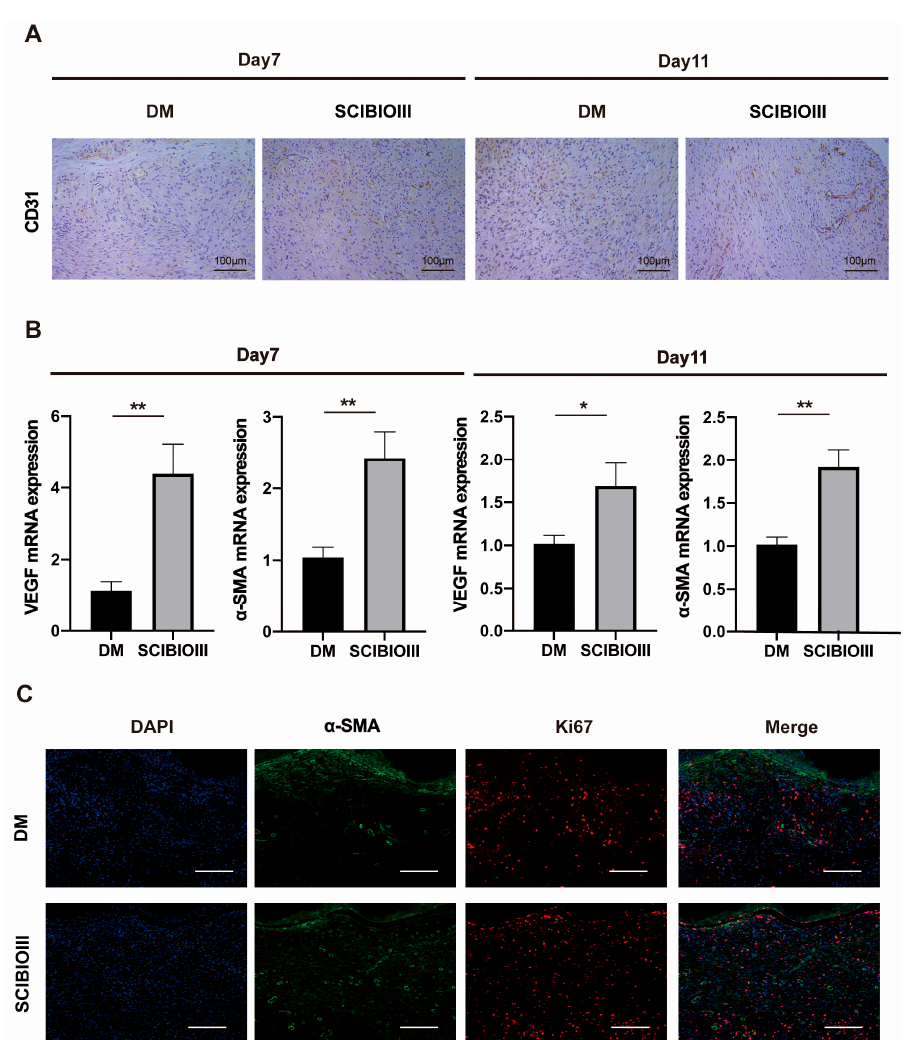
Figure 8. ( A ) IHC results of CD31 from days 7 and 11 from the skin tissue of diabetic mice treated or untreated with SCIBIOIII (representative images). ( B ) qPCR results, the mRNA levels of VEGF and α − SMA on days 7 and 11 from the skin tissue of diabetic mice treated or untreated with SCIBIOIII by qPCR ( n = 5). ( C ) Immunofluorescence staining results of skin tissue sections on day 11. Scale bar: 100 µ m. * p < 0.05, ** p <